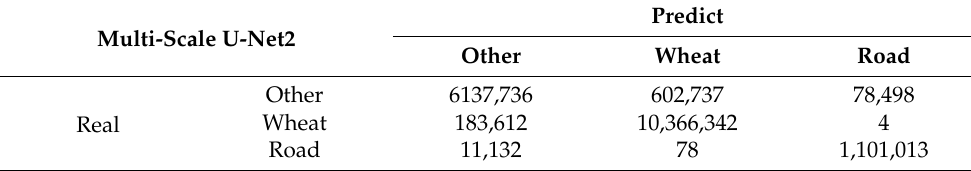
Table 7. Multi-Scale U-Net2 Confusion